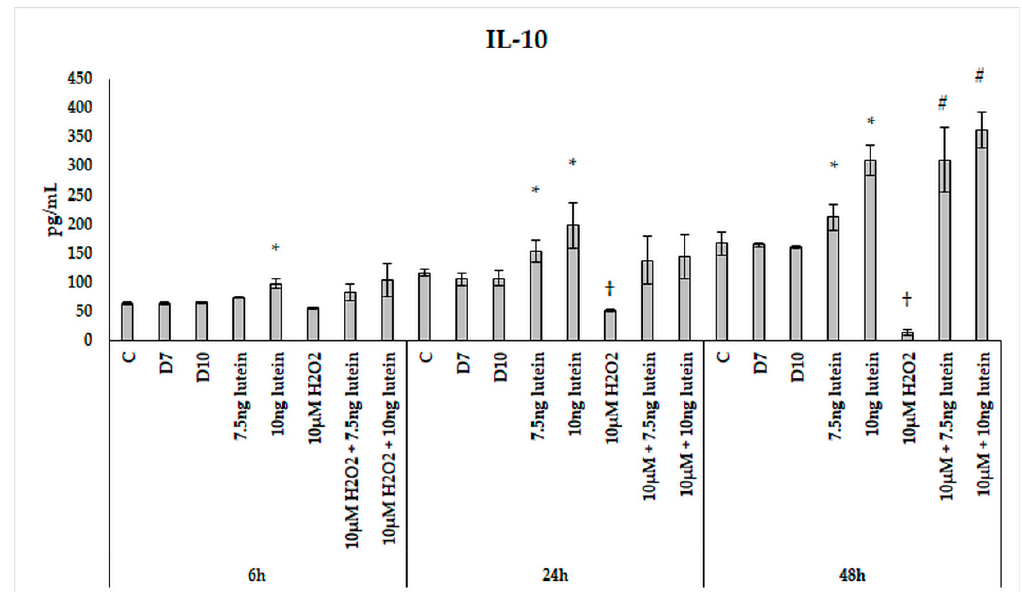
Figure 16. IL-10 secretion in lutein and in H 2 O 2 -treated BV-2 cells. The columns represent the mean values, and error bars indicate the standard deviation (SD) of three independent experiments ( n = 3), each performed in triplicate, and are presented relative to own control cells. * indicates statistical significance of lutein treatments versus controls; † indicates statistical significance of H 2 O 2 -treated cells compared to controls; # indicates statistical significance of combined (lutein with H 2 O 2 ) treatments compared to H 2 O 2 treatments; the level of significance was p < 0.05. Abbreviations: C marks the appropriate absolute controls at 6, 24 and 48 h; D7 means the same amount of DMSO as 7.5 ng/ µ L of lutein was added; D10 signs the same amount of DMSO as 10 ng/µL of lutein was used in the treatments.